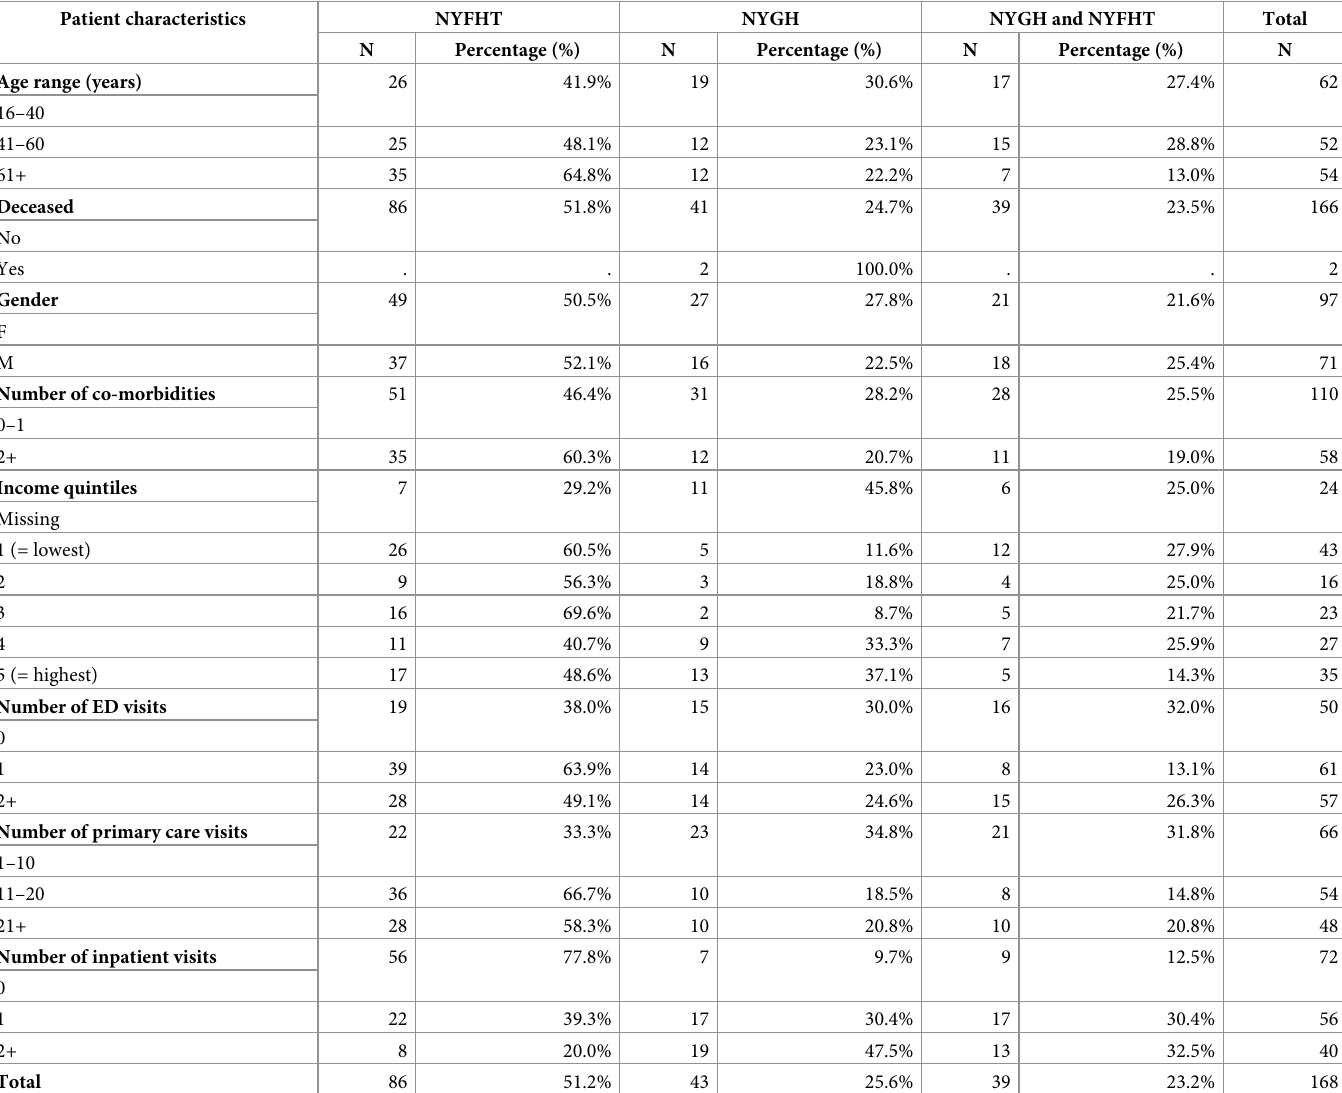
Table 1. Characteristics of patients with schizophrenia identified in primary care (NYFHT) and hospital (NYGH) data, and those identified in both settings. Patient